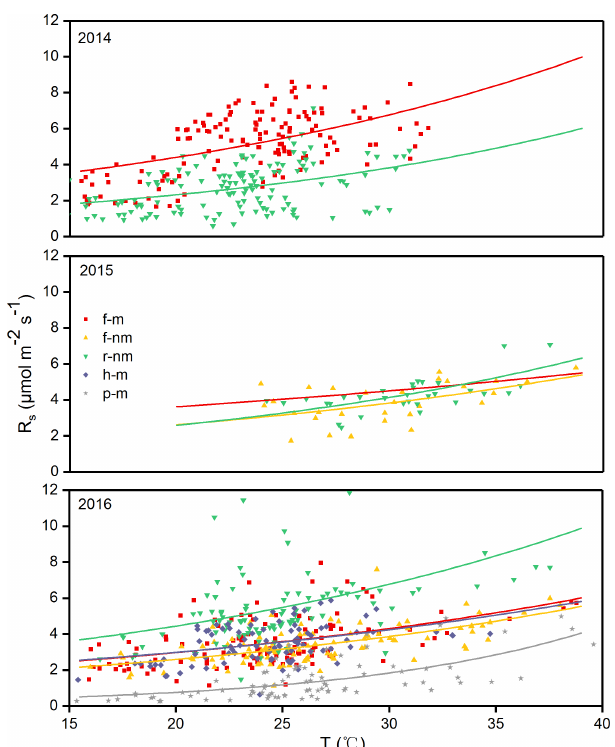
Figure 5. Relations between soil respiration and soil temperature at different locations in the mulched and non-mulched fields. The data represent the means ± standard deviations (SDs) of three replicates. The regression lines for the different locations were fitted using Eq. (4), and the regression equations are shown in Table 2 (f-m, h-m, and p-m represent furrow, planting hole, and plastic mulch, respec- tively; f-nm and r-nm represent furrow and ridge in non-mulched fields, respectively).